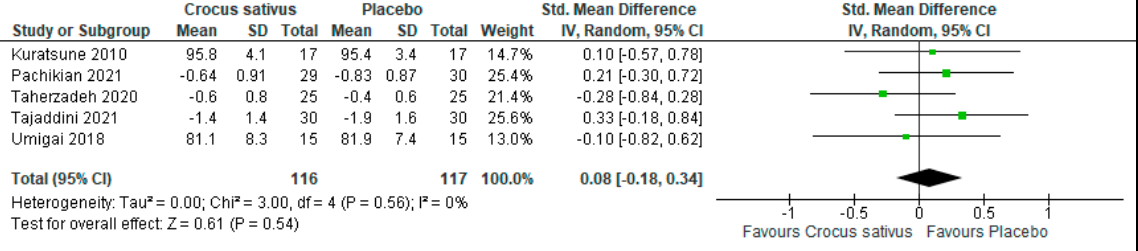
Figure 8. Forest plot for the outcome sleep efficiency [24,27,29–31]. Note: Line indicates confidence interval and the green square indicates effect estimate. Black diamond indicates cumulative effect estimate and its confidence interval.